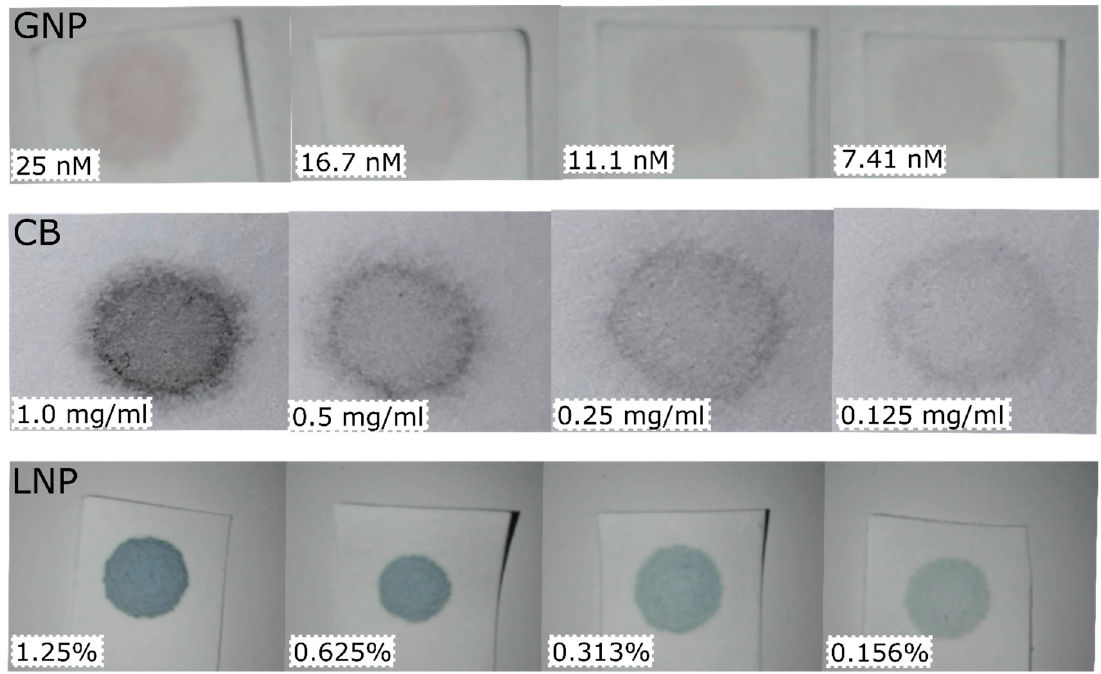
Figure 2. Exemplary images taken with the Huawei of the filter papers with nanomaterials on them at various concentrations. Top row are gold nanoparticles (GNP). Middle row are carbon black nanoparticles (CB). Bottom row are latex nanoparticles (LNP). Particle concentration of the solutions used is indicated in the left bottom corner of each image.